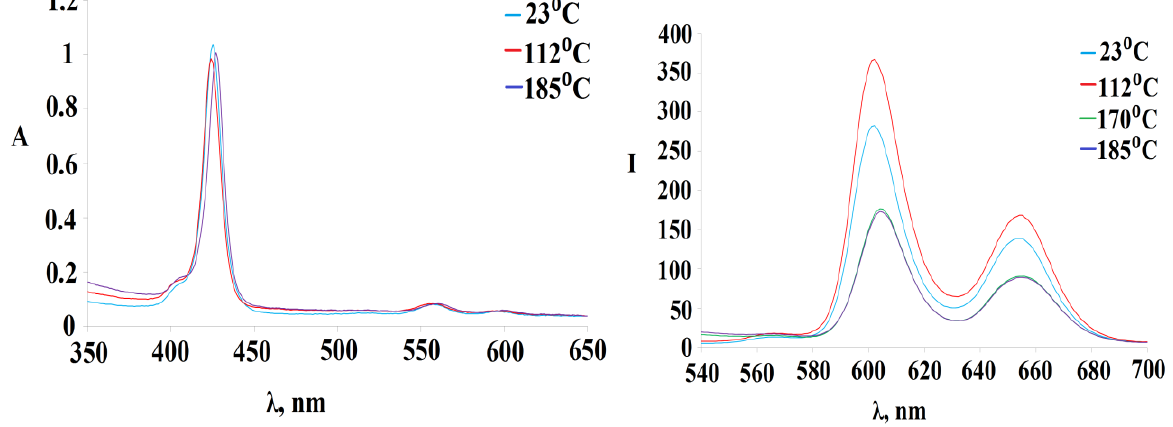
Figure 9. Dependence of UV − Vis spectrum and fluorescence spectra of (Sn(OH) 2 P) 4 (PdCl 2 ) 4 on the solution temperature.